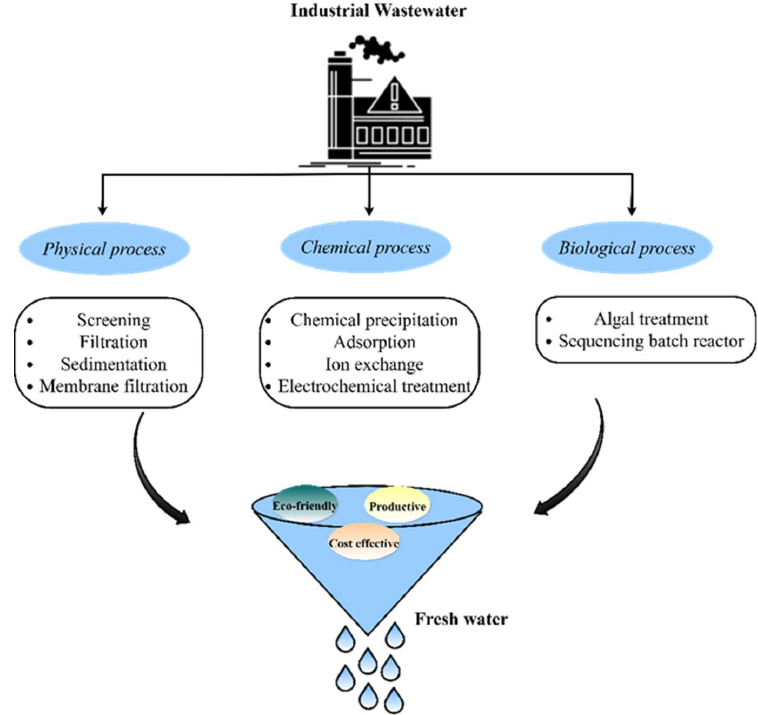
Figure 10. Industrial wastewater treatment.